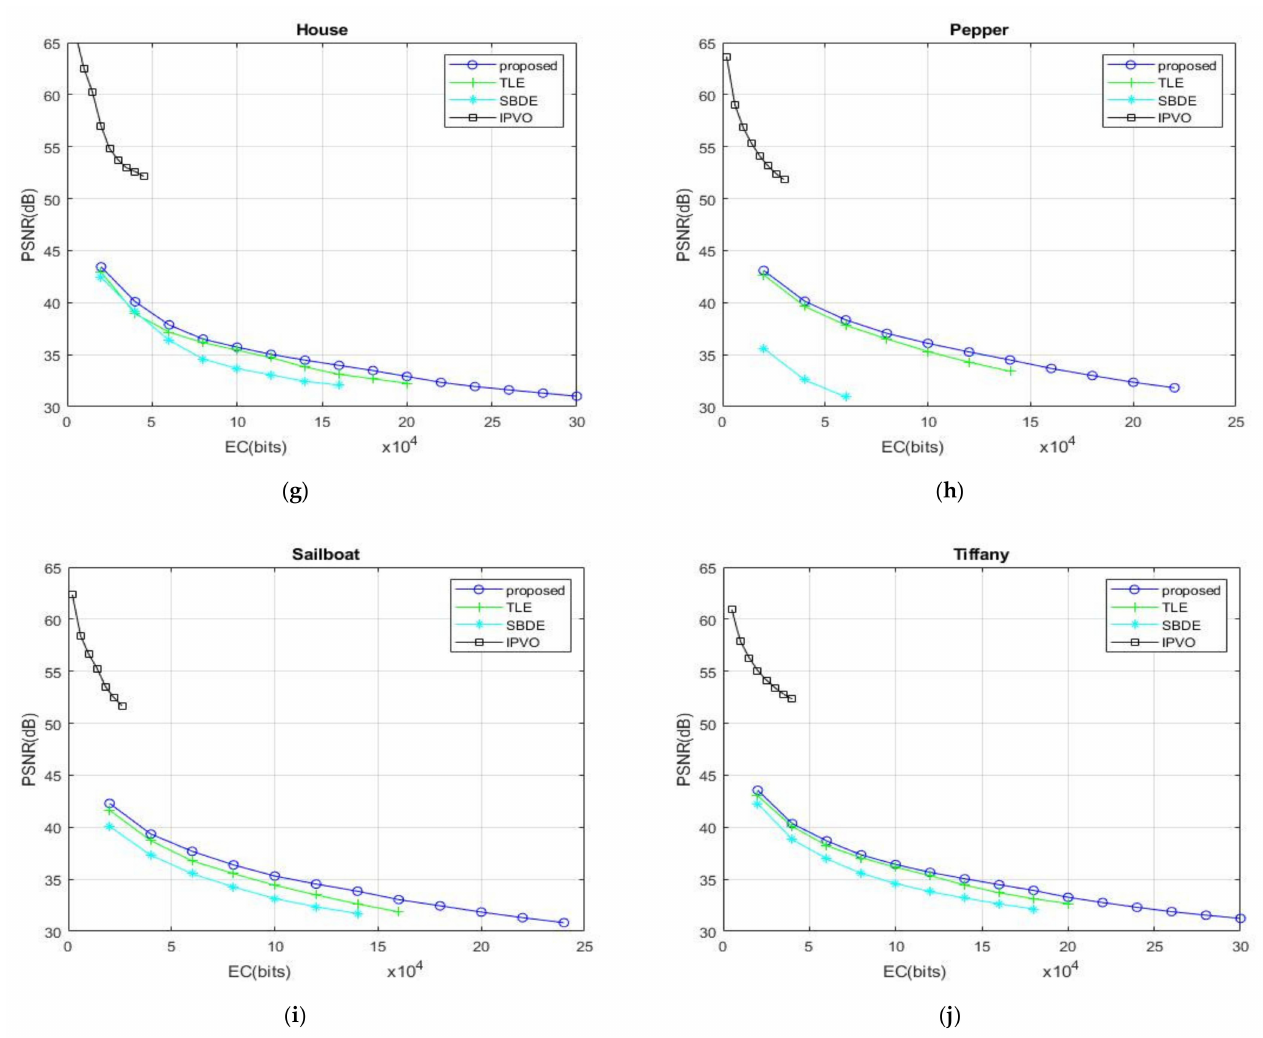
Figure 9. Comparison of PSNRs and ECs between the proposed triple-RDH, TLE, SBDE, and IPVO methods using ten test images ( a ) Lena ( b ) Baboon ( c ) Barbara ( d ) Boat ( e ) Elaine ( f ) F16 ( g ) House ( h ) Pepper ( i ) Sailboat ( j )